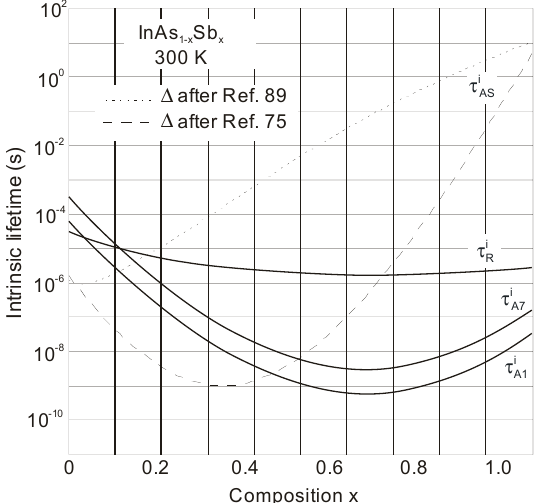
Figure 18. Intrinsic InAs 1 − x Sb x Auger and radiative recombination carrier lifetimes at room temperature. 𝜏 (cid:3020)(cid:2869)(cid:3036) is calculated assuming spin-orbit-splitting bandgap energies after [75,89] (after [91]).